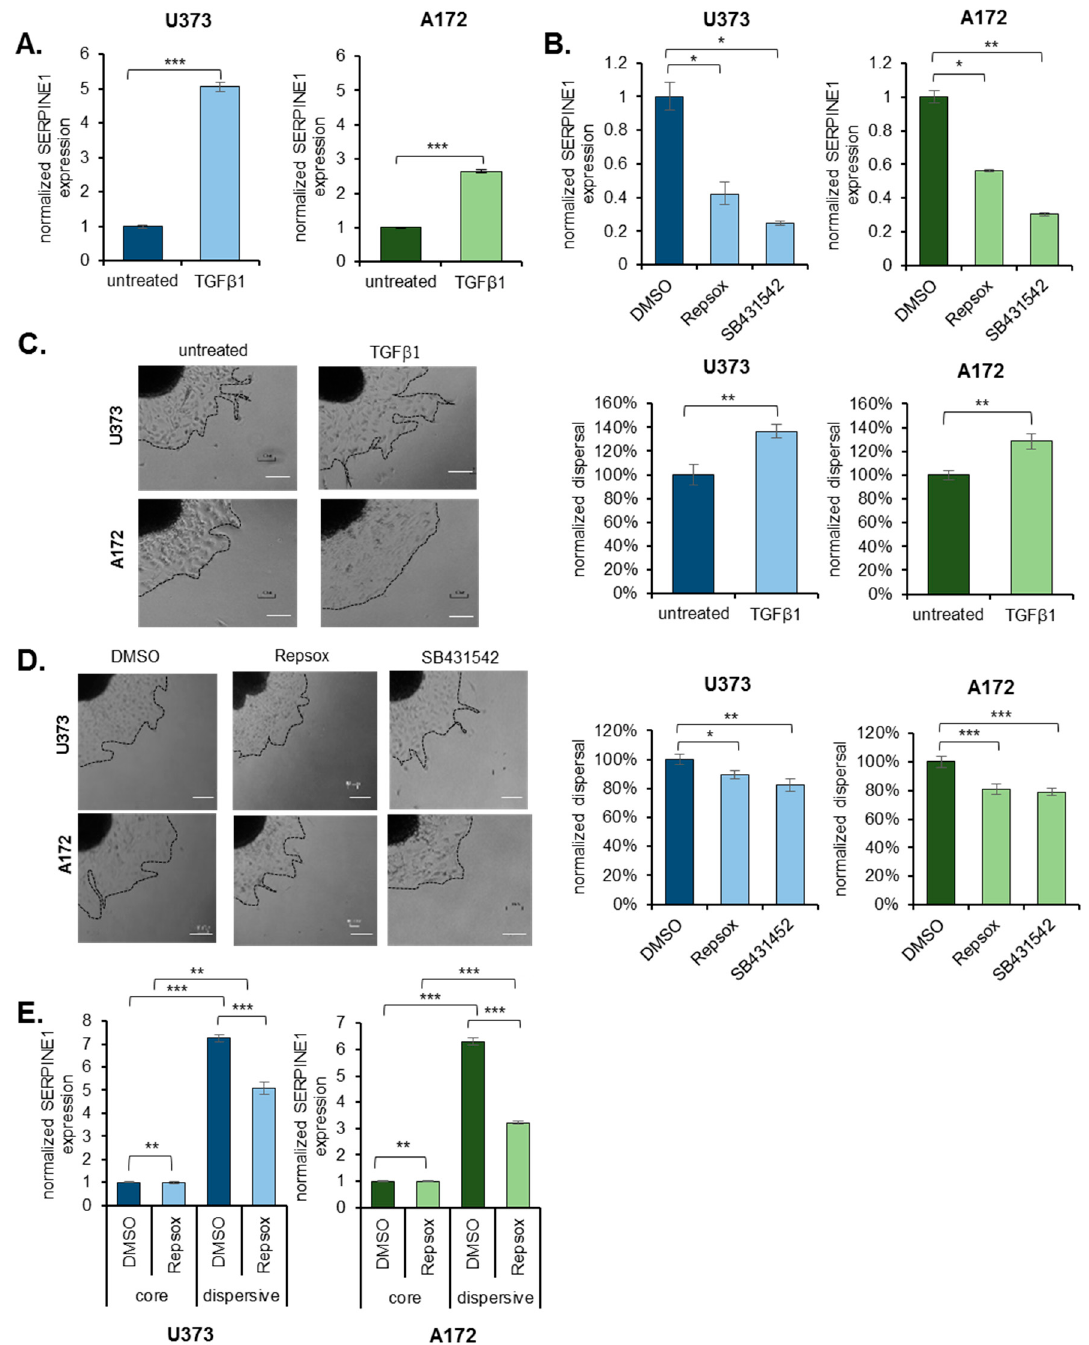
Figure 4. TGF β is an upstream regulator of SERPINE1 . ( A ) qRT-PCR analysis of SERPINE1 expression upon TGF β treatment in U373 and A172 cells. ( B ) qRT-PCR analysis of SERPINE1 expression upon TGF β inhibitor (Repsox and SB431542) treatment in U373 and A172 cells; ( C ) dispersal assay that shows TGF β induces dispersal of U373 and A172 ( n = 12 spheroids for each condition, scale bar: 300 µ m). ( D ) Dispersal assay that shows Repsox or SB431542 reduce dispersal of U373 and A172 spheroids ( n = 24 spheroids for each condition, scale bar: 300 µ m); ( E ) SERPINE1 upregulation in dispersive cells in the presence of TGF β inhibitor Repsox for U373 and A172 cells. (*, ** and *** denote p < 0.05, p < 0.01 and p < 0.001 respectively, two-tailed Student’s t -test).